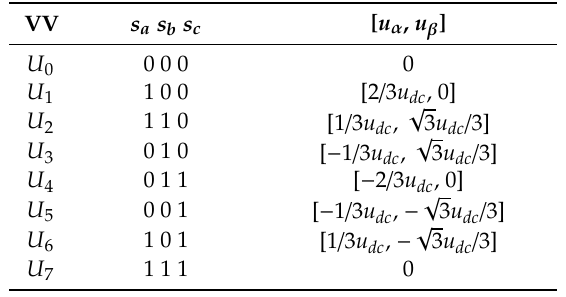
Table 2. VVs in α - β coordinate